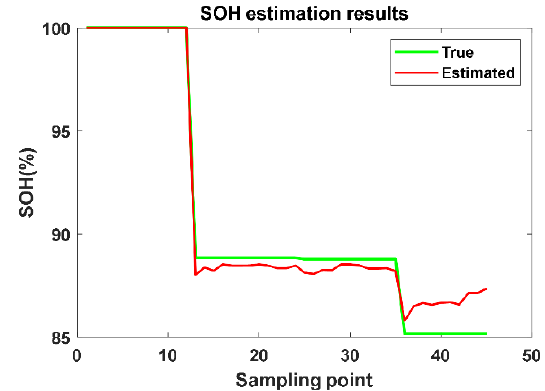
Figure 12. SOH estimation result of B1